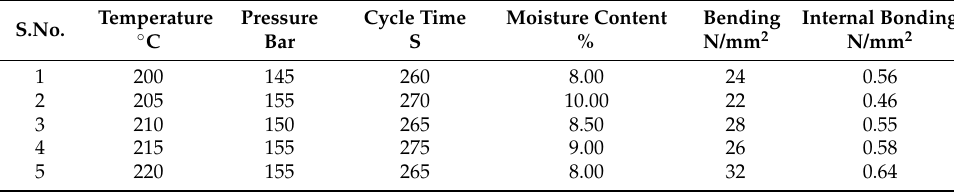
Figure 7. MDF parameter percentage representation. Table 3. Selected experimental data.